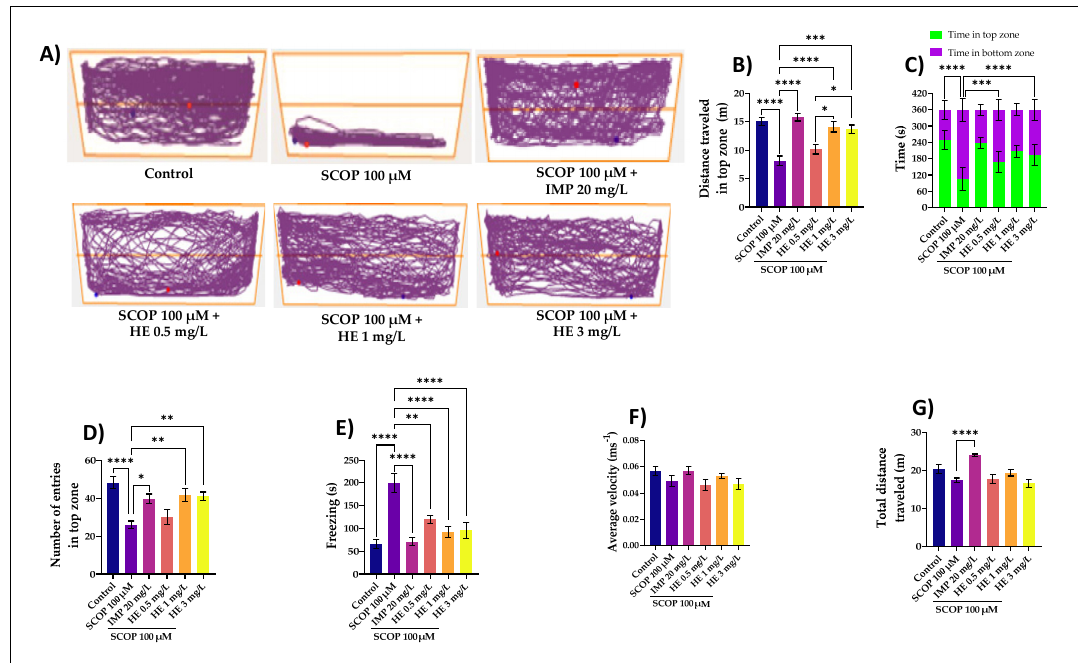
Figure 2. Hericium erinaceus ethanolic extract (HE: 0.5, 1, and 3 mg/L) improved the locomotion pattern and reduced anxiety in the novel tank-diving test (NTT). ( A ) Representative locomotion-tracking pattern of the control, scopolamine (SCOP: 100 μ M), Hericium erinaceus (HE: 0.5, 1, and 3 mg/L) and imipramine (IMP: 20 mg/L) treated groups. ( B ) Representation of the distance traveled in the top zone in different groups. ( C ) The time spent by zebrafish in the top/bottom zone of the tank in different groups. ( D ) Representation of the number of entries in the top zone by zebrafish in the tank in different groups. ( E ) Representation of the freezing activity by zebrafish in the tank in different groups. ( F ) Representation of the average velocity of zebrafish in the tank in different groups. ( G ) Representation of the total distance traveled by zebrafish in the tank in different groups. Values are means ± S.E.M. ( n = 10). For Tukey’s post hoc analysis: **** p < 0.0001, *** p < 0.001, ** p < 0.01, and * p < 0.05.